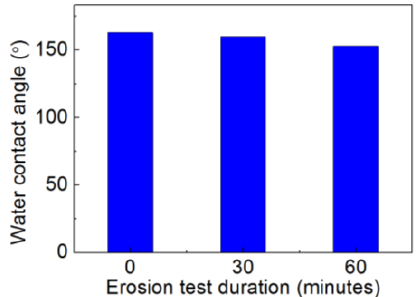
Figure 10. Water contact angle before and after erosion test from water impinging for silica-based nano-coatings for as-prepared sample, after 30 min test and after 60 min test.